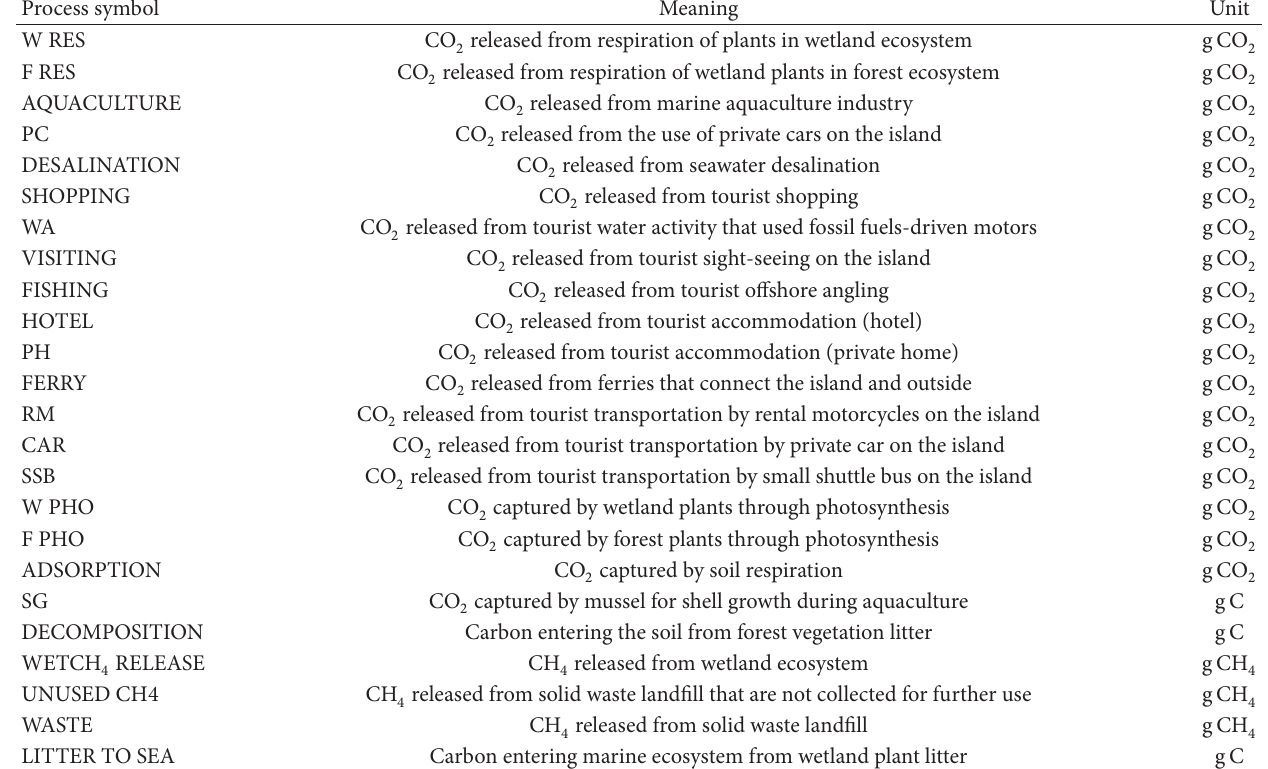
Table 4: Processes of the